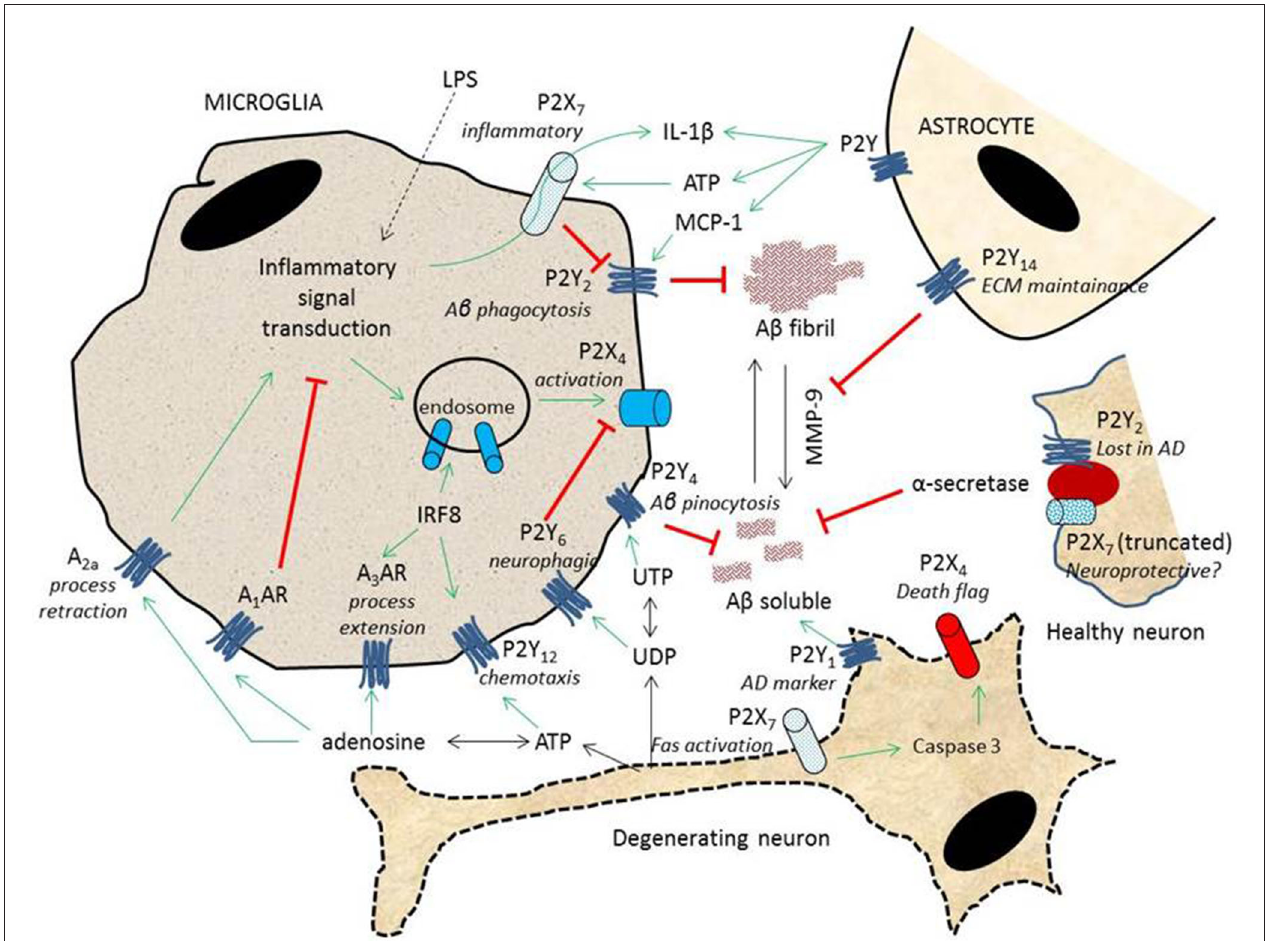
P2Y 12 and adenosine A 3 receptors and its neurophagic activity through P2Y 6 receptors. While A 1 adenosine receptors inhibit general inflammatory pathways, A 2a receptors activate COX-2 as well as retract microglial processes. In healthy neurons, truncated P2X 7 and P2Y 2 receptors enhance α -secretase activity, preventing the formation of amyloid deposits. Amyloid formation is also immediately cleared through microglial phagocytosis, mediated by P2Y 2 receptors; pinocytosis, through P2Y 4 receptors; and activity of MMP-9, inhibited by the tonic activity of P2Y 14